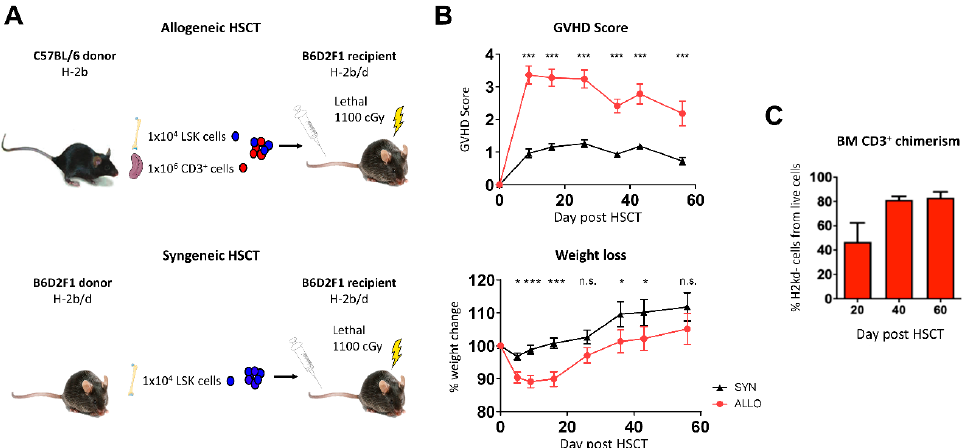
Figure 1. ( A ) Overview of the experimental hematopoietic stem cell transplantation protocol: allogeneic setting and syngeneic setting. ( B ) Clinical data of syn- and allo-HSCT mice (syn N = 19, allo N = 21). ( C ) Chimerism analysis of BM CD3 + cells in allo-HSCT mice (N = 6–7 per date). Error bars indicate mean ± SEM; * p ≤ 0.05; *** p ≤ 0.001; n.s. not significant by unpaired Student’s T-test.